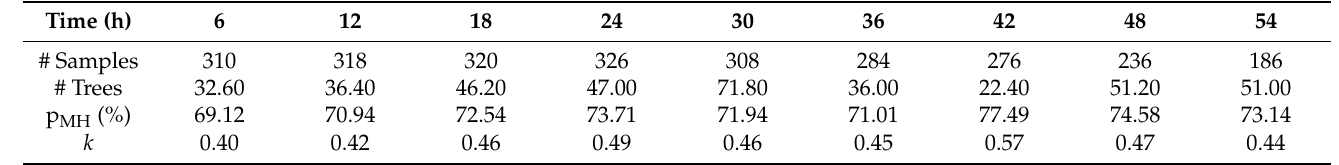
Table 3. As in Table 1, but for the Atlantic and NE Pacific oceans